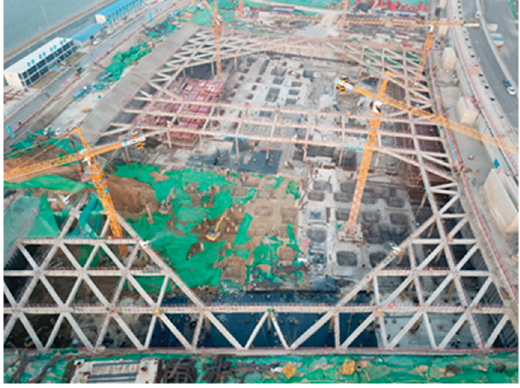
Figure 5. Schematic diagram of the foundation pit shape and surrounding environment.